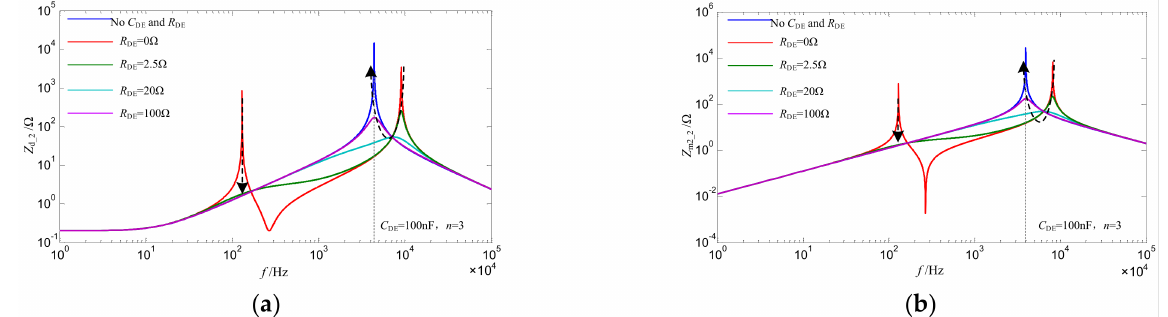
Figure 8. Amplitude–frequency curves of the terminal impedances, Z d_2 and Z m2_2 , with capacitor C DE and resistor R DE ( a ) at Stage 4 and ( b ) at Stage 7 and Stage 8.